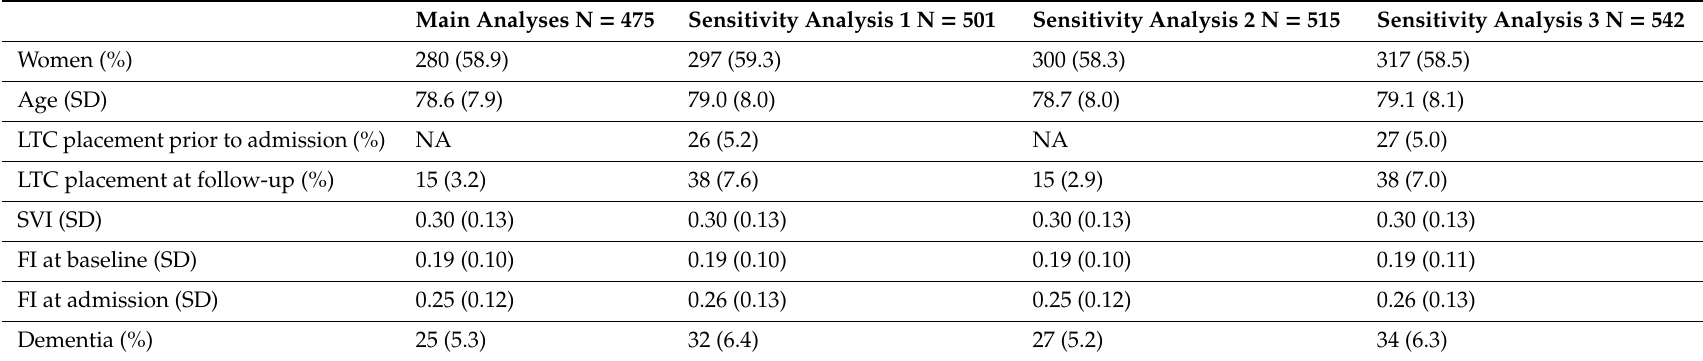
Table 2. Means (standard deviations) for continuous variables and N (%) for dichotomous variables for the main and sensitivity analyses.